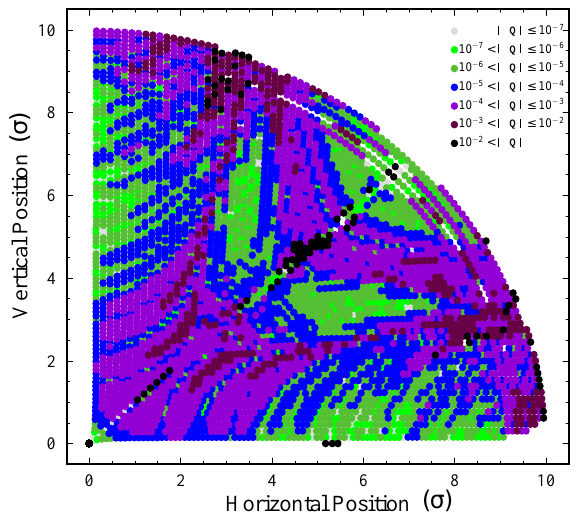
FIG. 4. (Color) Diffusion map for a model including a Möbius twist. The symbols are the same as in Fig. 2.